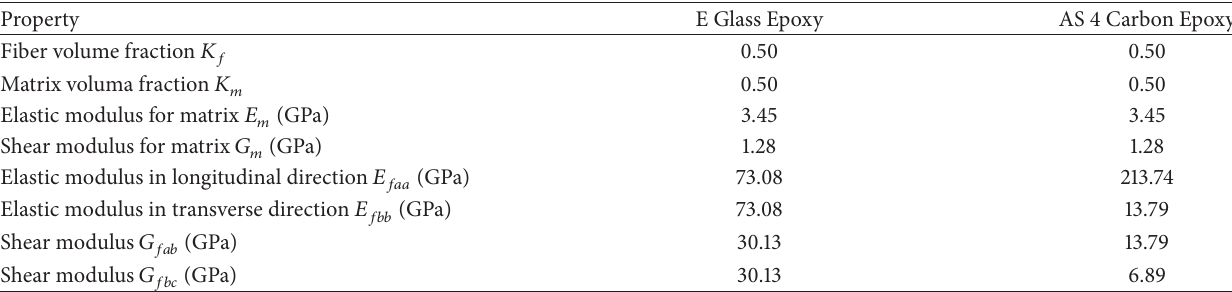
Table 1: Constituent’s elastic